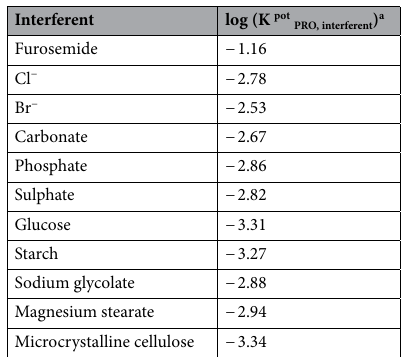
Table 2. Logarithmic selectivity coefficients (K pot PRO, interferent ) of PEDT-modified CPE. a Average of three